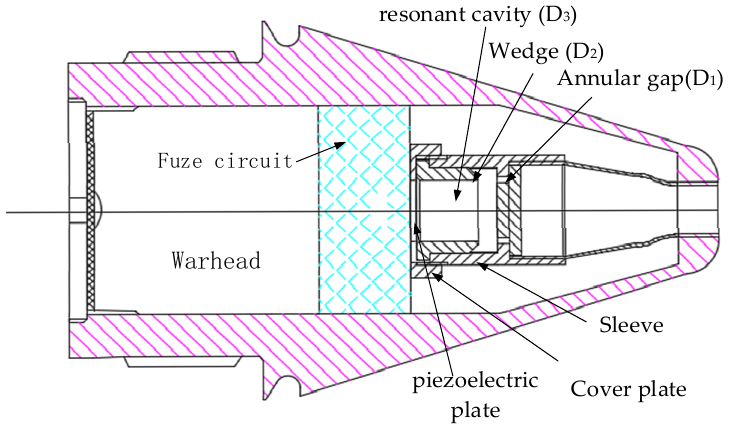
Figure 1. Experimental assembly drawing.